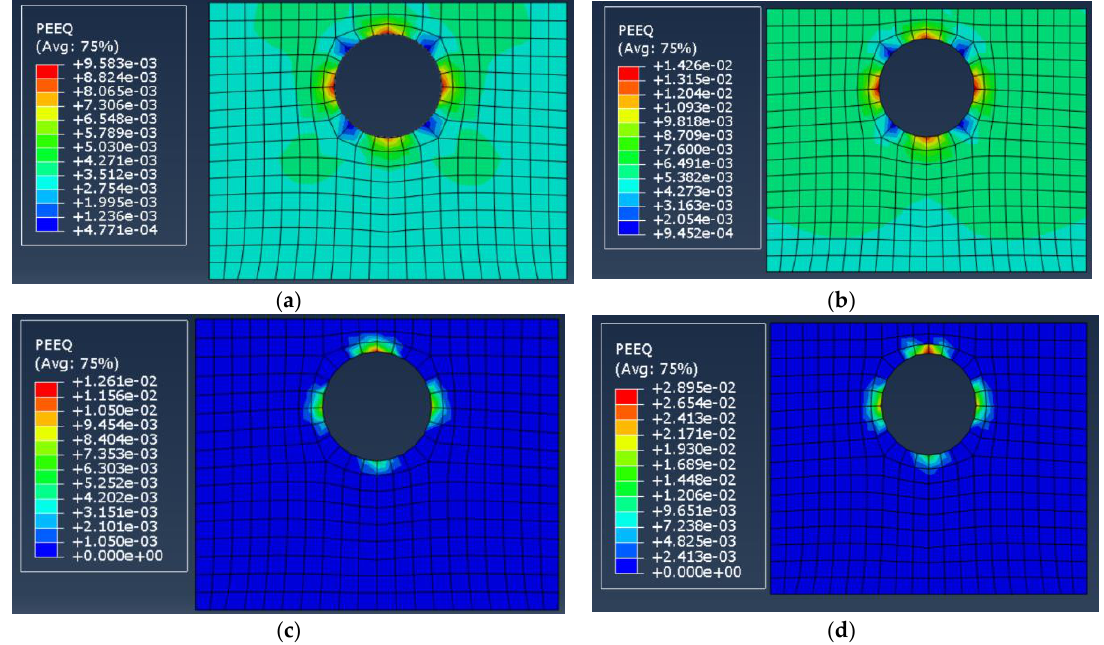
Figure 15. Distribution of equivalent plastic strain in: ( a ) the kinematic hardening model under 0.4 g peak ground acceleration (PGA), ( b ) the kinematic hardening model under 0.83 g PGA, ( c ) the Mohr–Coulomb model under 0.4 g PGA, and ( d ) the Mohr–Coulomb model under 0.83 g PGA.